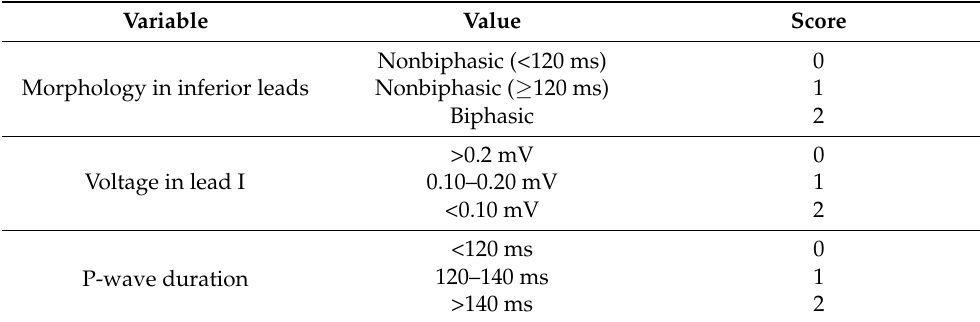
Table A1. MVP score calculation.